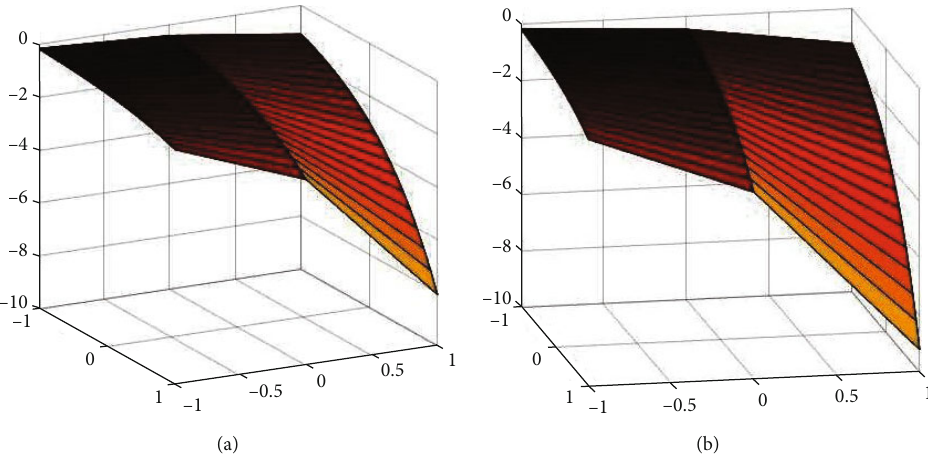
Figure 8: The di ff erent fractional-order result of μ ð χ , ξ , I Þ at δ = (a) 0 : 8 and (b) 0 : 6 of example.